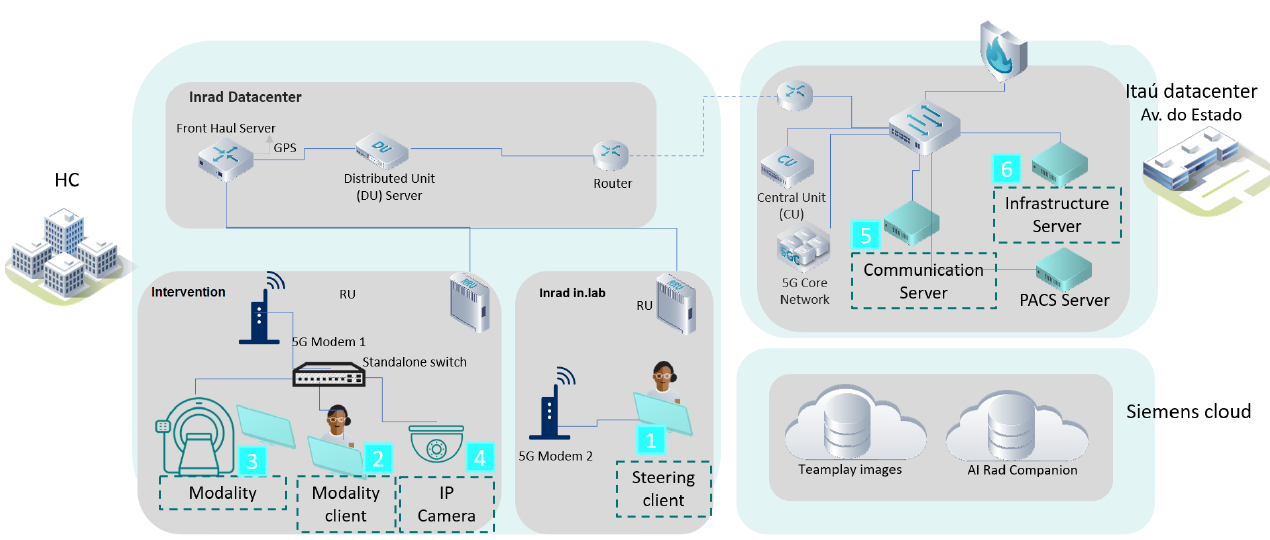
Figure 19. Architecture with the 5G network for Modality/sVC